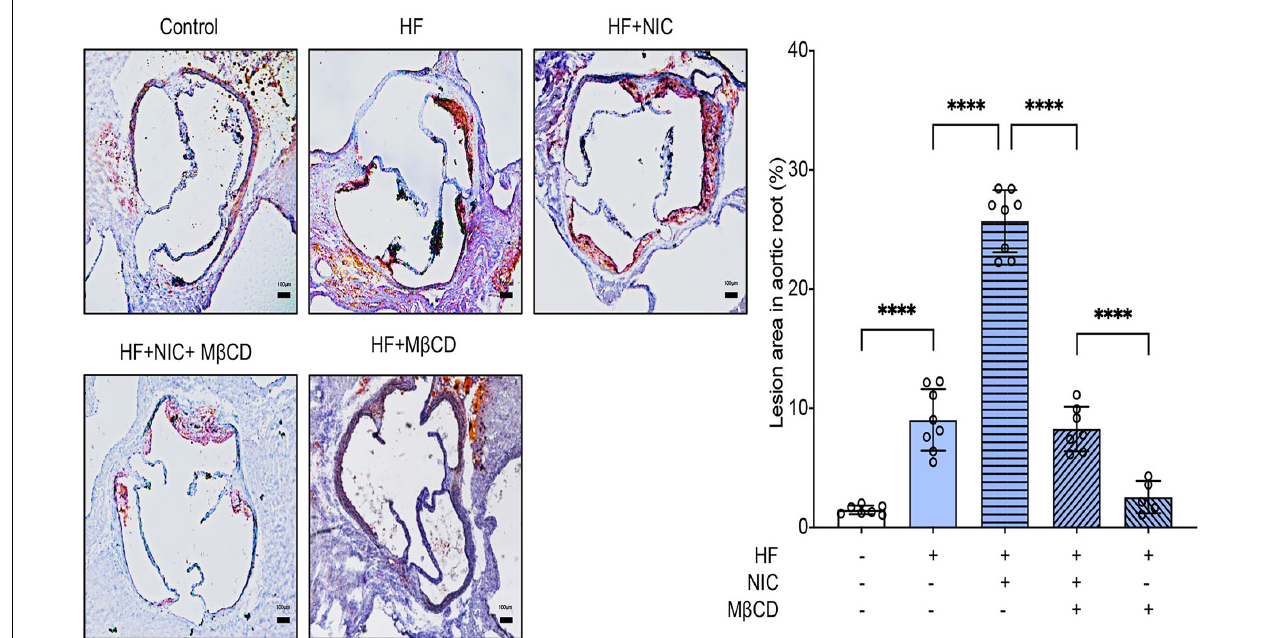
FIGURE 4 | M β CD attenuated the formation of atherosclerotic plaque in nicotine-accelerated atherosclerosis in apoE − / − mice. Mice were randomly divided into control (wild type, normal diet, n = 7), high fat (HF) (apoE − / − , n = 8), nicotine (apoE − / − , n = 8, high-fat diet), nicotine plus M β CD (apoE − / − , n = 7, high-fat diet), and M β CD (apoE − / − , n = 5, high-fat diet) groups. Oil Red O staining showing the atherosclerotic lesions in aortic root and quantitative analysis of atherosclerotic lesion area in the aortic root. Black bars = 100 µ m. All data are represented as mean ± SD. ANOVA test followed by Holm–Šídák post-hoc test was used for statistical analysis. ∗∗∗∗ p < 0.0001. NIC, nicotine; M β CD, methyl- β -cyclodextrin; HF, high-fat diet.